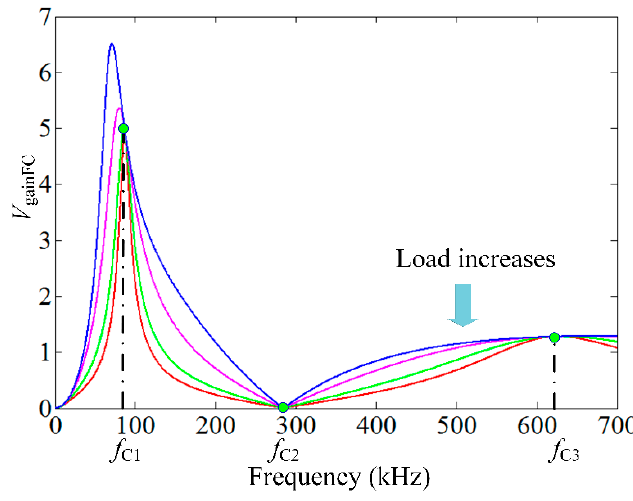
Figure 2. DC voltage gain curves of the CLTCL circuit.